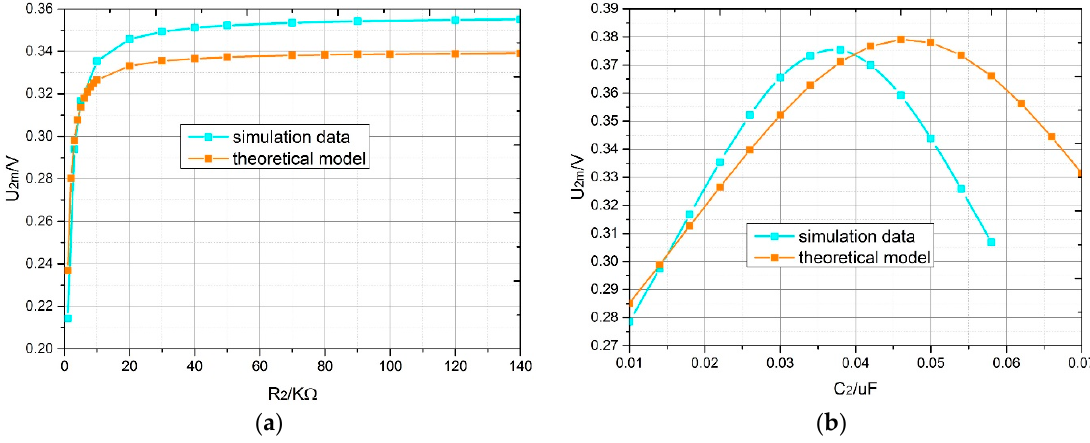
Figure 10. Variation of the output voltage amplitude with the capacitance and resistance of load in the theoretical model and simulation; α = 1°: ( a ) the resistance of load; ( b ) the capacitance of load.